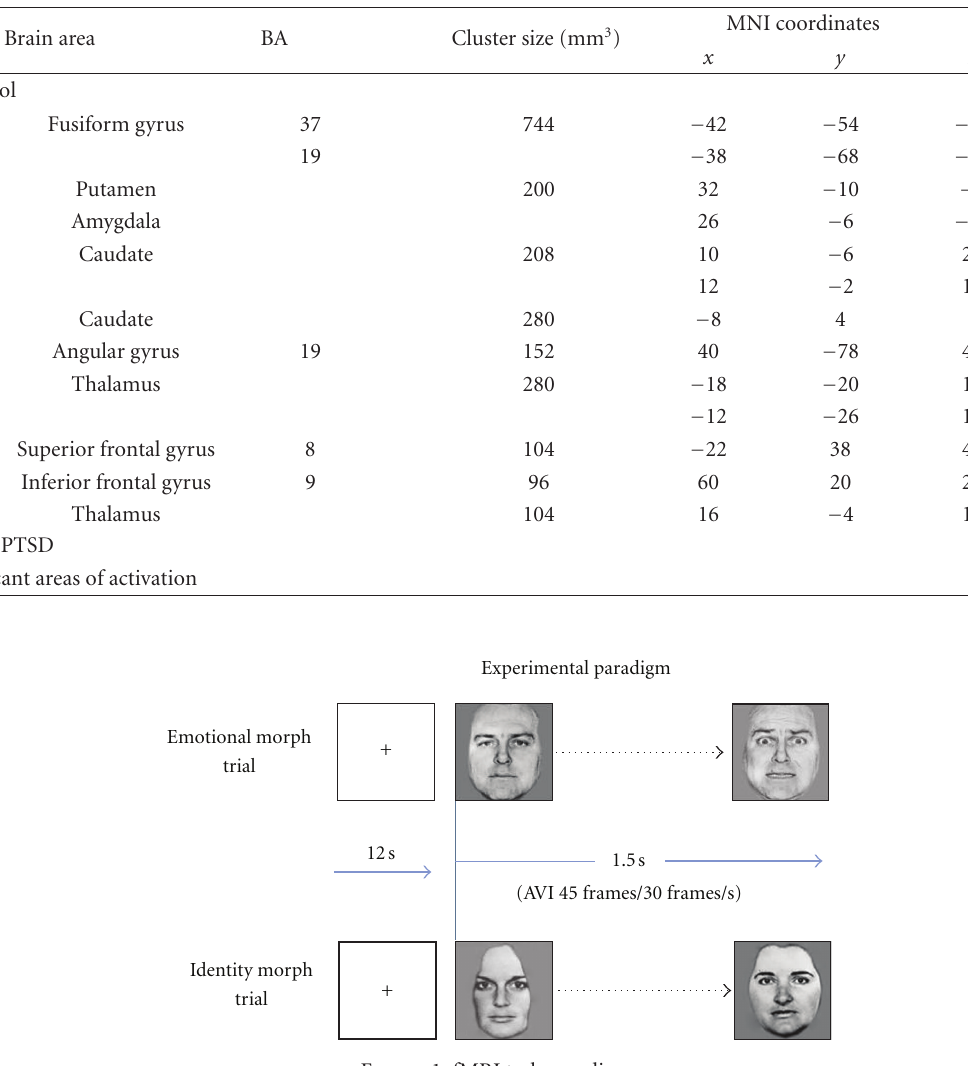
Table 2: Brain areas where significant main e ff ects of group were observed.